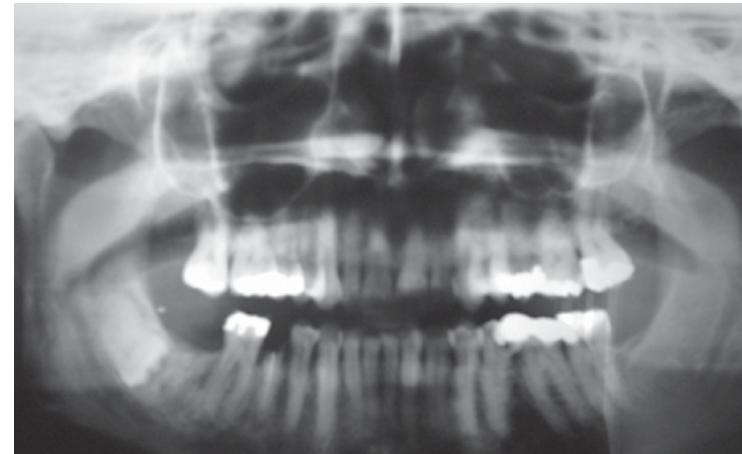
Figure 1- Panoramic radiograph showing a radiopaque lesion in the right oral mucosa